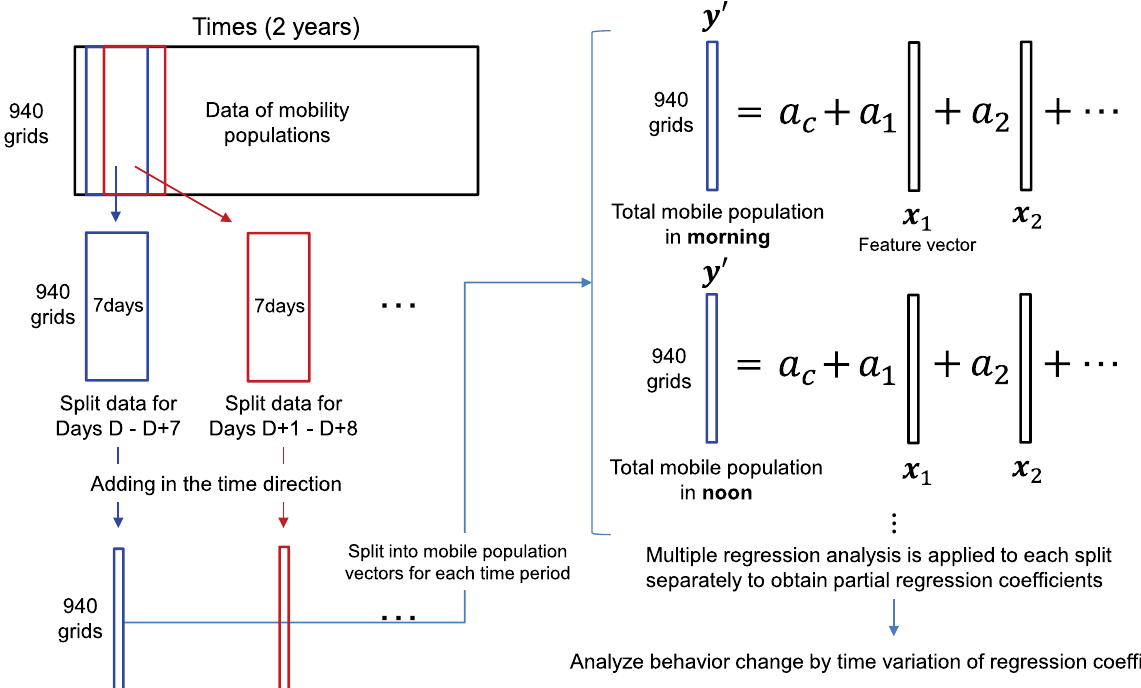
Figure 4. An overview of the analysis